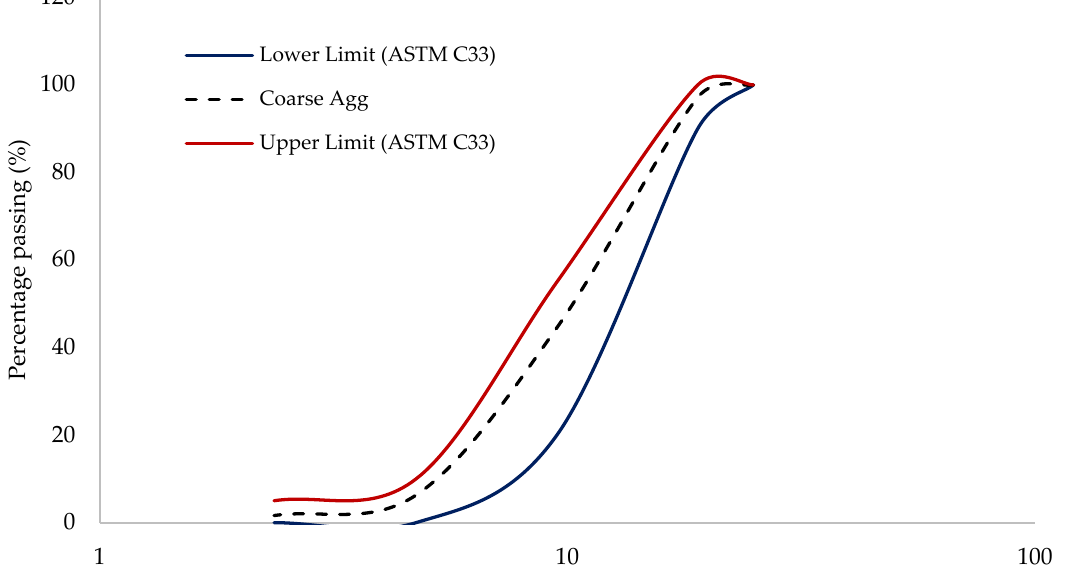
Figure 2. Fine aggregate gradation.